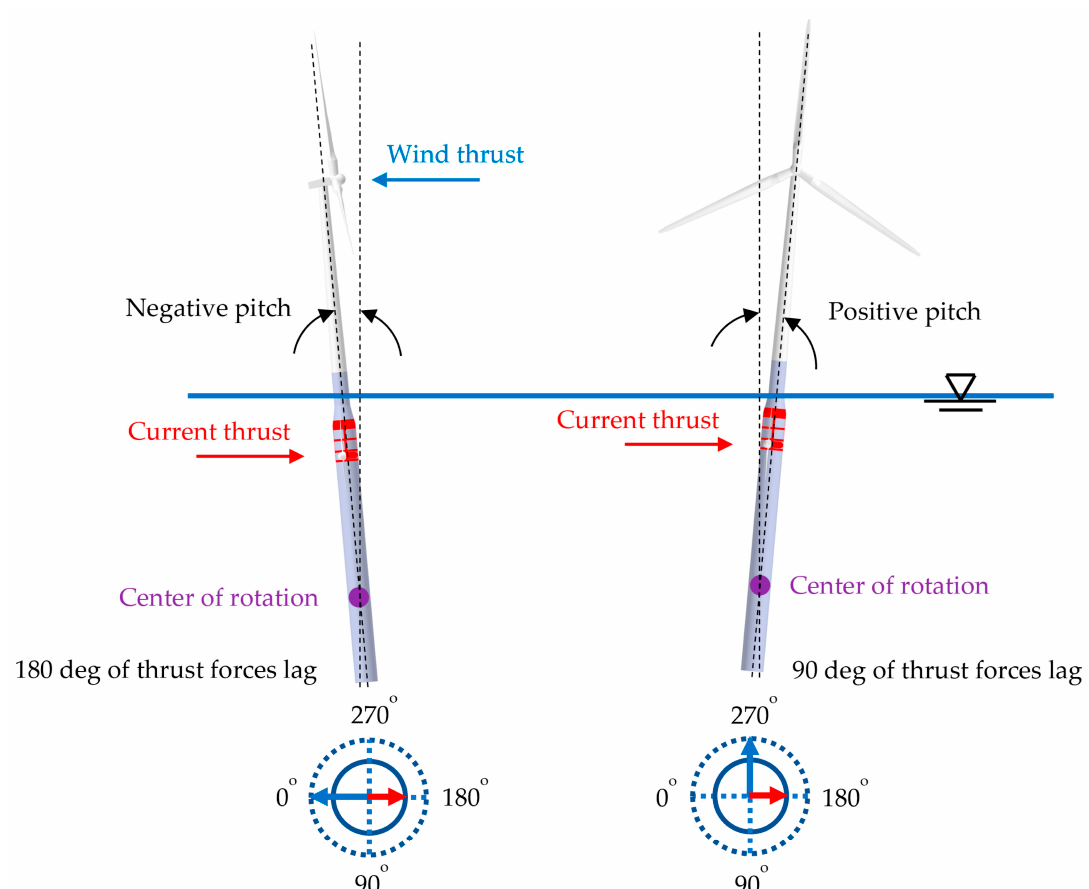
Figure 6. Combinations of force